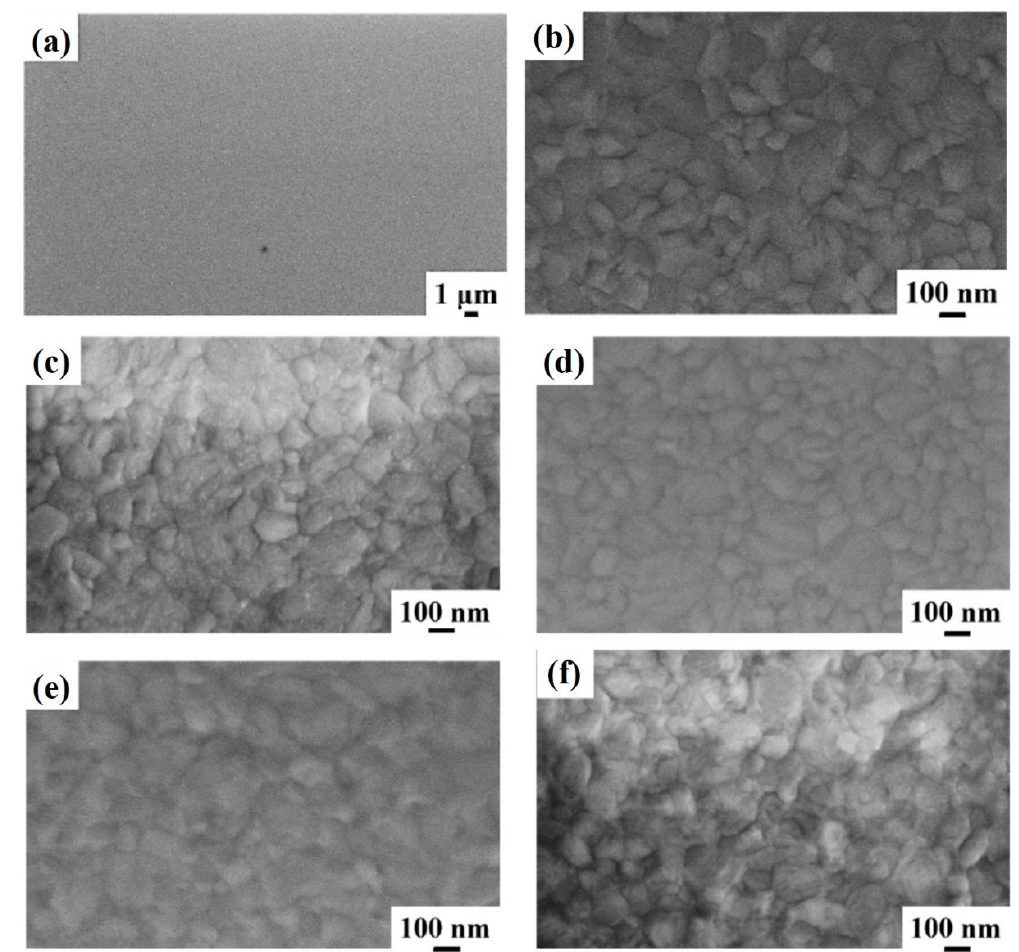
Figure 2. Representative plan-view SEM images of the Al surface for the sample: ( a , b ) 1A (Si/TiN/Ti/Al) with increasing magnification from ( a ) to ( b ); ( c ) 1E (Si/TiN/Ti/Al + 350 °C 30 min); ( d ) 1F (Si/TiN/Ti/Al + 400 °C 15 min); ( e ) 1G (Si/TiN/Ti/Al + 450 °C 15 min); ( f ) 1H (Si/TiN/Ti/Al + 500 °C 15 min).